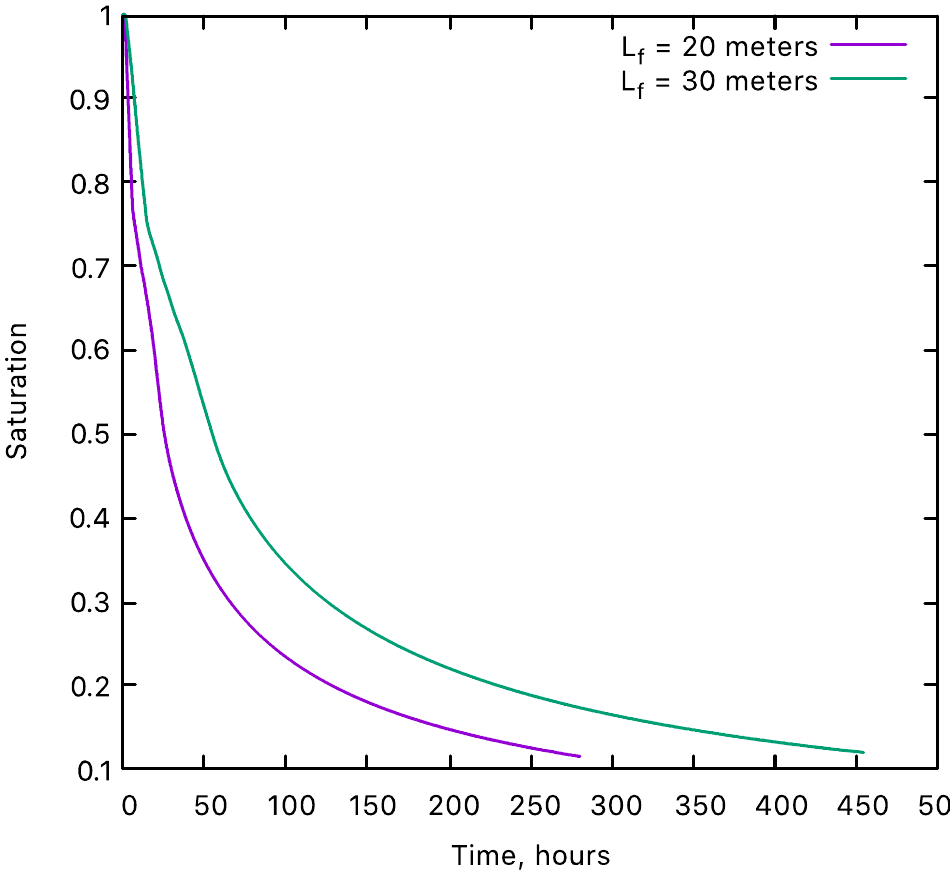
Figure 26. The dependence of mean saturation of hydraulic fracturing fluid in elliptic zone on time.